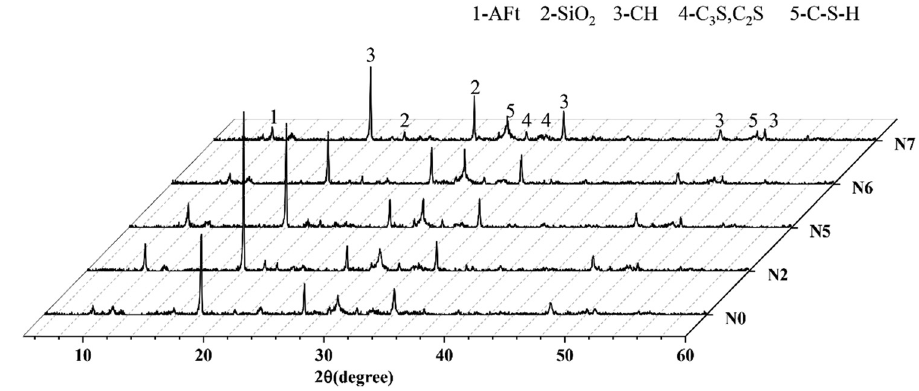
Figure 6: XRD patterns of hydration for 28